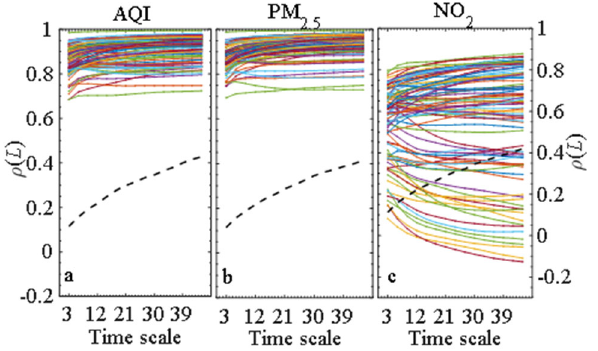
Figure 1. HXA ‐ based cross ‐ correlation coefficient of the AQI ( a ) and the two pollutants ( b , c ) between every pair of cities with respect to time scale. The black dotted line denotes the critical value under 0.05 significant level. The area above this line means correlation significance.